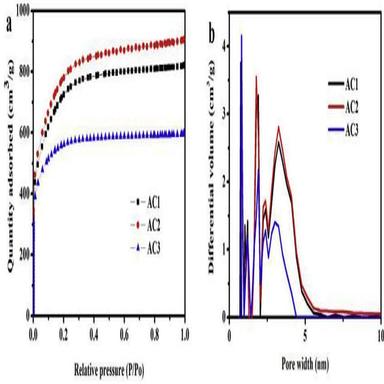
(a) Nitrogen adsorptionedesorption isotherms and the pore size distribution of AC1, AC2 and AC3.